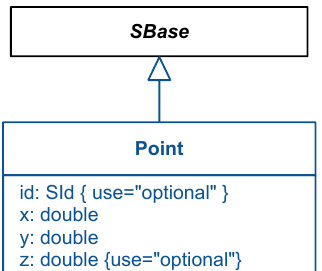
Figure 2: The definitions of the Point